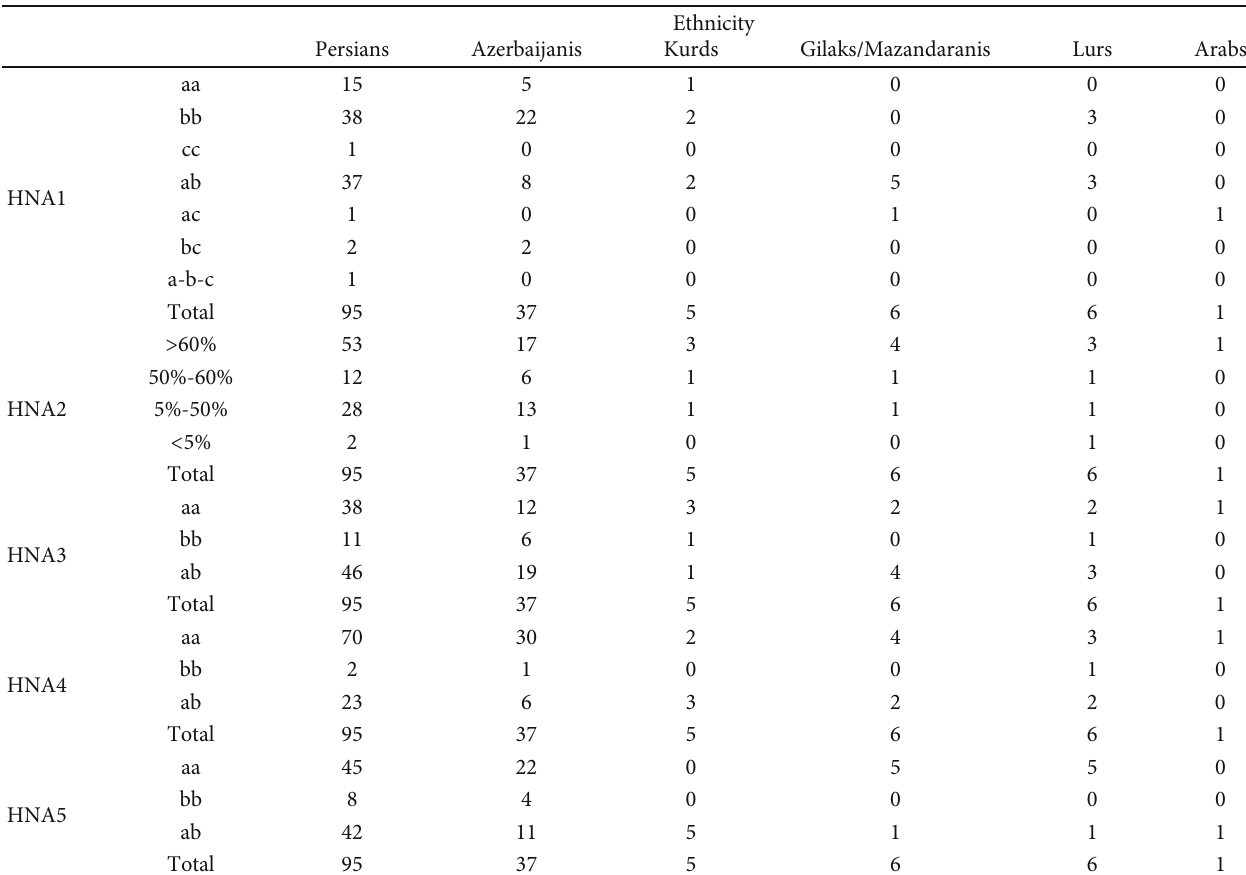
Table 6: The distribution of HNA allele frequencies among di ff erent ethnicities in the study cohort. Ethnicity Persians Azerbaijanis Kurds Gilaks/Mazandaranis